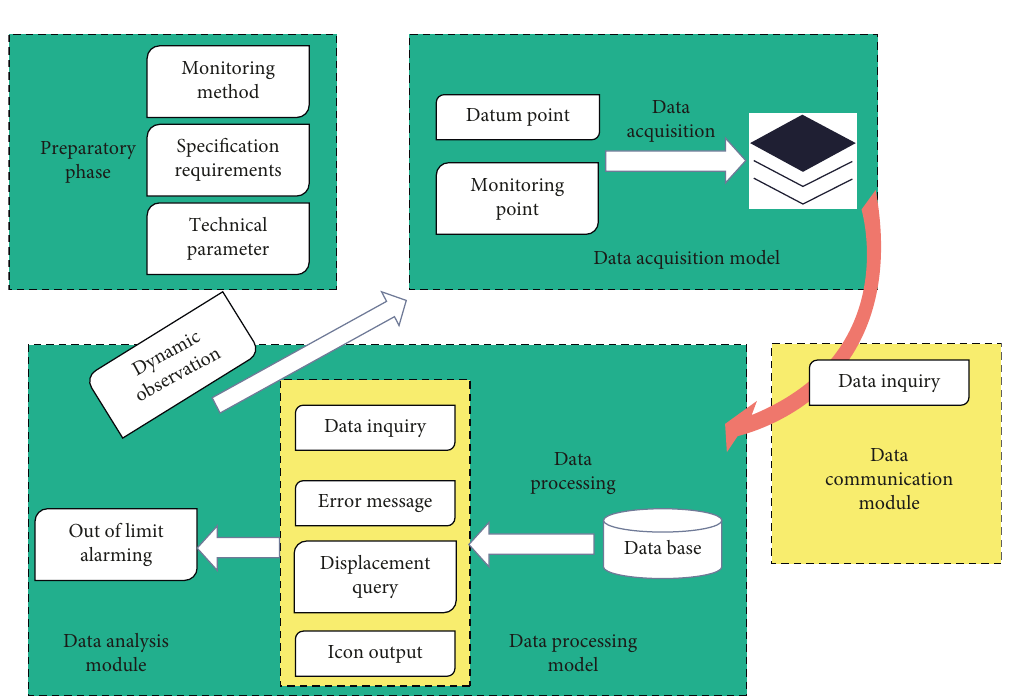
Figure 6: Characteristics of several